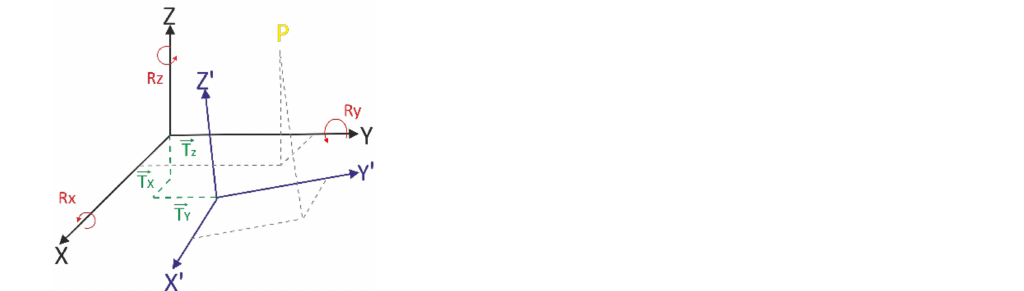
Figure 4. Diagram of the seven-parameter transformation parameters. Own study based on